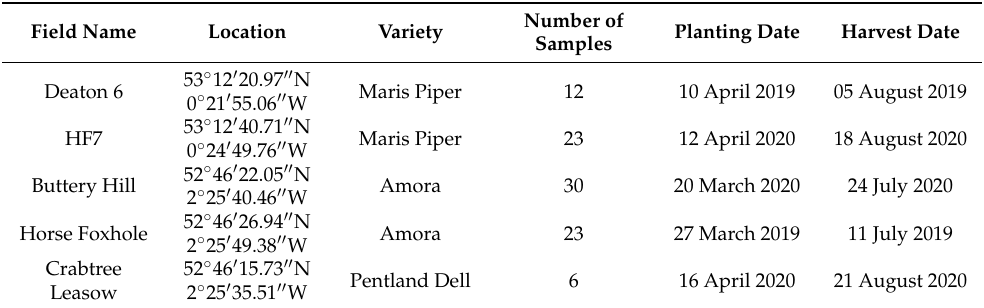
Table 1. Summary of the location and key production information of the study